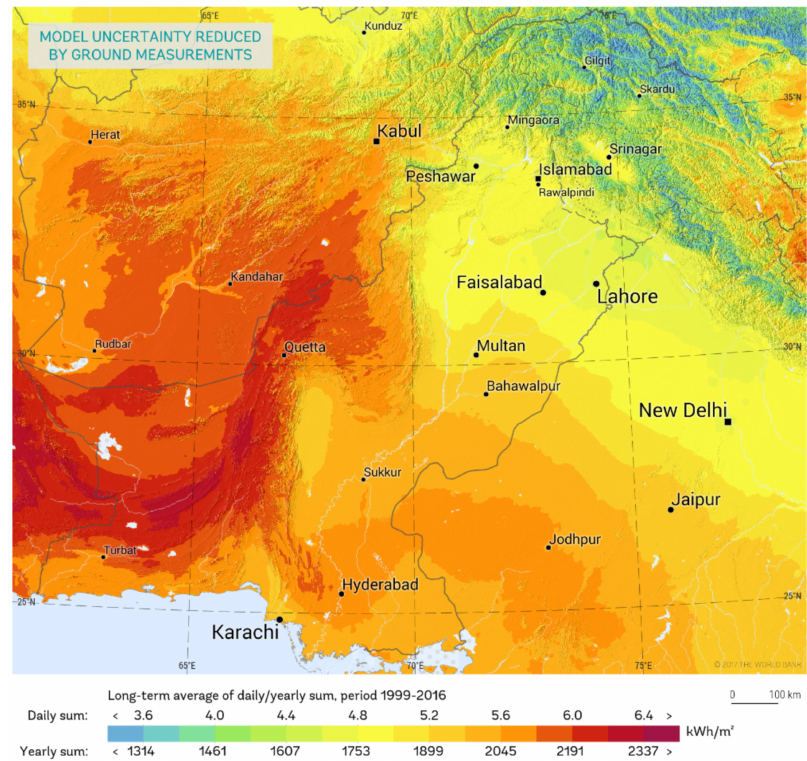
Figure 8. Global horizontal irradiance map [10,16,17].